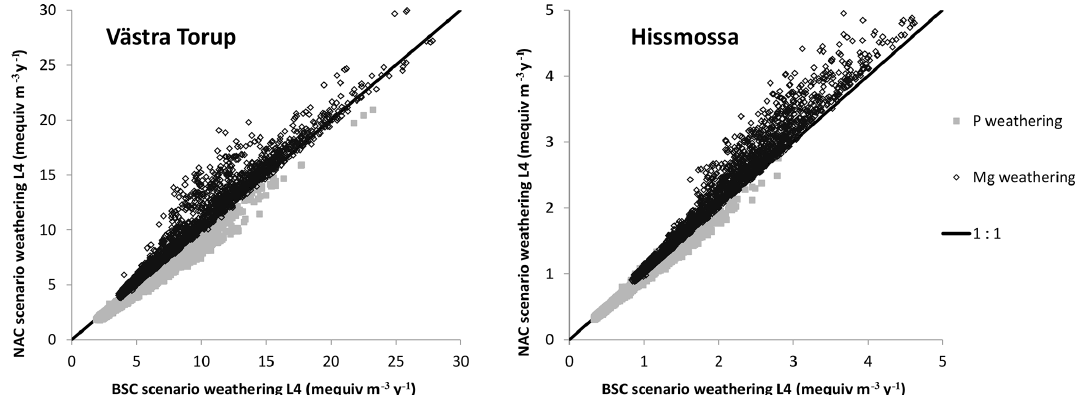
Figure 5. Comparison of weathering rates of Mg and P in soil layer L4 in the non-acidification scenario NAC and the base scenario BSC (mequivm − 3 yr − 1 ). With the mineralogy of these sites, Mg is only weathered from silicate minerals, and P is only weathered from apatite. One dot represents 1